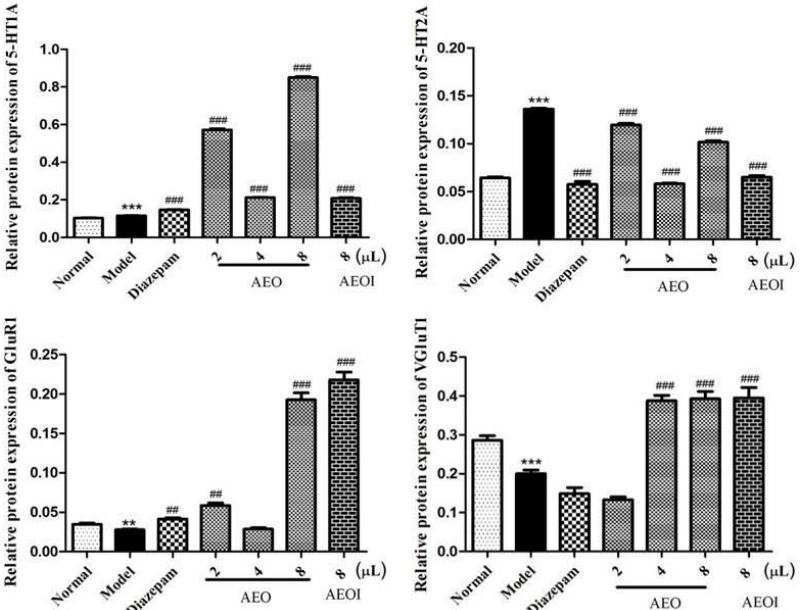
Figure 4. Effects on the protein levels of 5HT1A, 5HT2A, GluR1 and VGluT1 via AEO inhalation. All values are expressed as the means ± SD ( n = 3). ** p < 0.01, *** p < 0.001 vs. normal group; ## p < 0.01, ### p < 0.001 vs. model group.